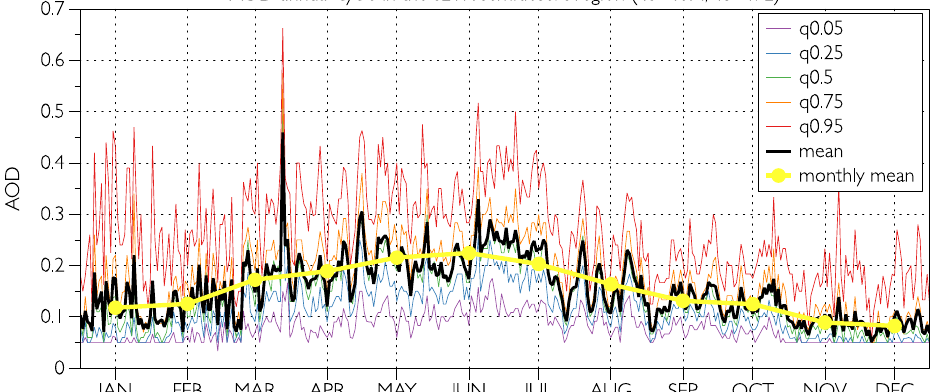
Figure 6. Annual variation of daily AODs according to the data of the EUMETSAT-CMSAF product based on the SEVIRI instrument on the METEOSAT-9 satellite [59] for the arid region of the southern ETR (45–48° N, 43–47° E) for the period 2007–2012. Different quantiles are shown with thin lines. The black thick line is the regional daily averaged AOD. The yellow line is the regional monthly averaged AOD.